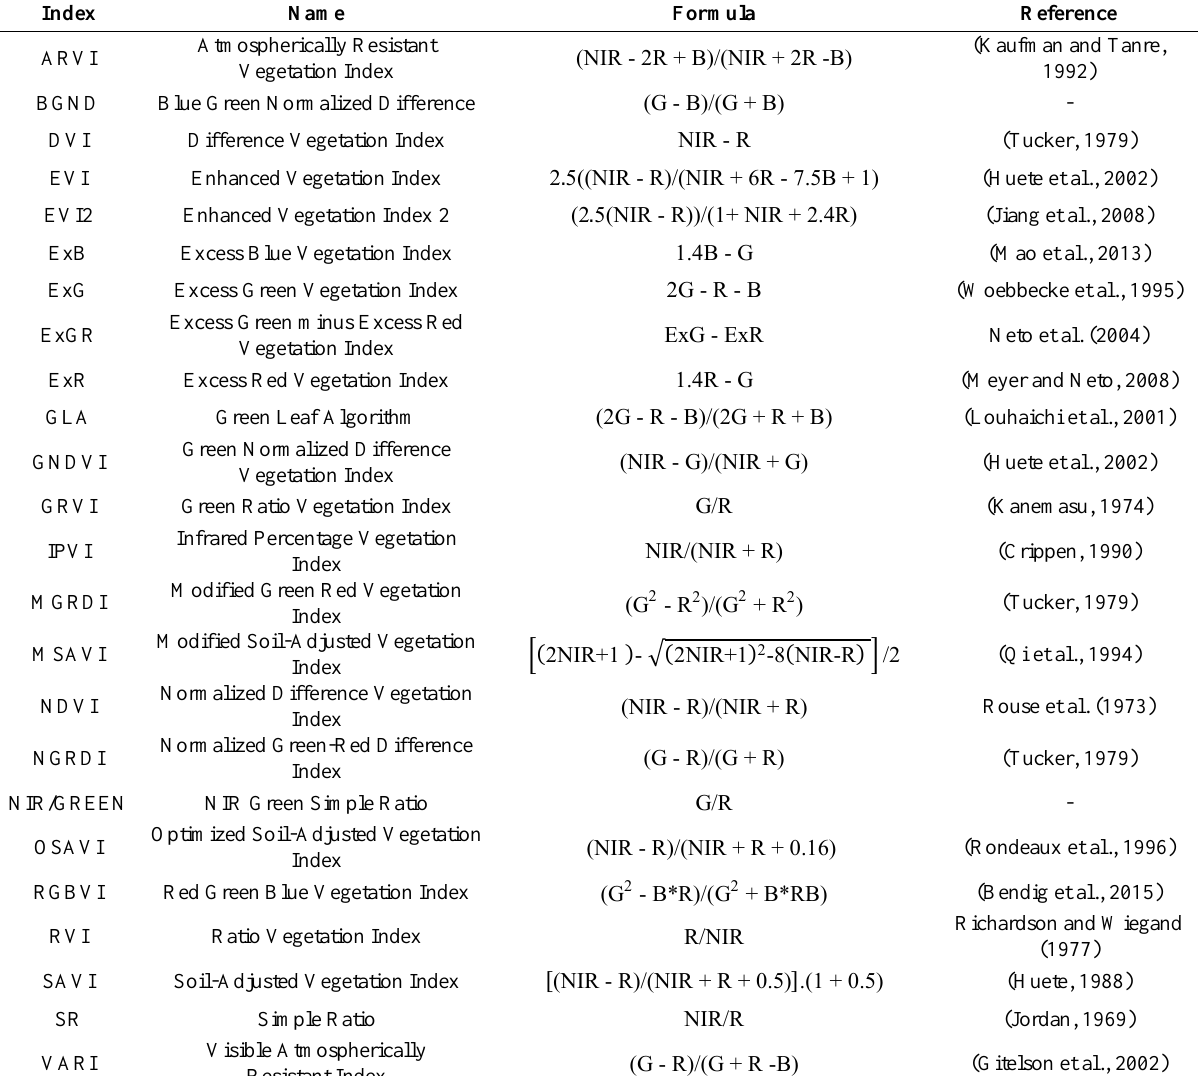
Table 1. Summary of the vegetation indices (VIs) used in this study for pasture biomass estimation.